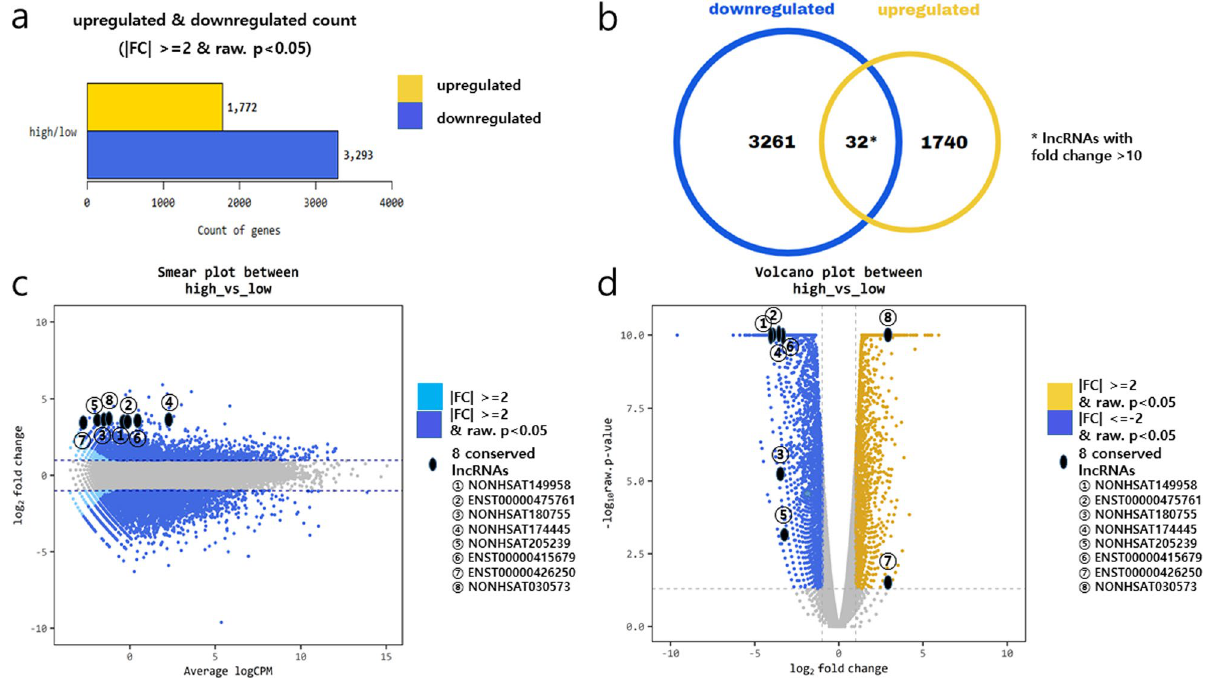
Figure 3. A total of 1772 genes were upregulated and 3293 genes were downregulated with statistical significance (a,b). In the Venn diagram, upregulated or downregulated lncRNAs with more than tenfold changes are featured (b) . The smear plot (c) and volcano plot (d) between the high and low fatty change groups are shown. Eight conserved lncRNAs are placed and featured in each plot (c,d) ZFLNCT14973, ZFLNCT11394, ZFLNCT04118, ZFLNCT10393, ZFLNCT15818, ZFLNCT03884, and ZFL- NCT04874) out of 28 lncRNAs were confirmed to be conserved, as evaluated by ZFLNC BLASTN.2.7.1 + (Table 2).